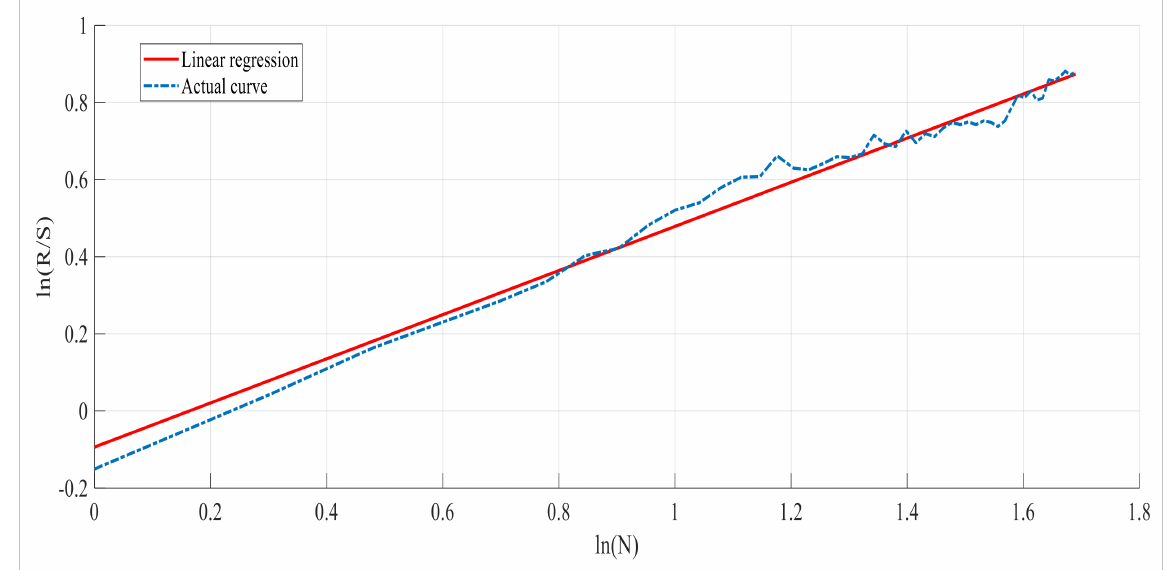
Figure 13. RS method to estimate the Hurst exponent H . According to Equation (24), the estimated value of the Hurst exponent H is the slope in Figure 13. The calculated result is 0.5723. The predicted RUL is obtained through 1000 trials of Monte Carlo simulation [28,33]. The histogram and PDF of 100 RUL prediction are shown in Figure 14.